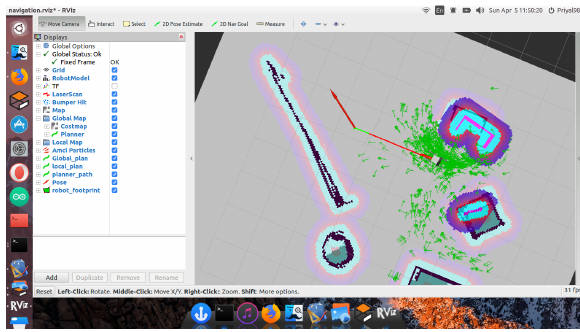
Figure 11. Robot reaching goal through amcl